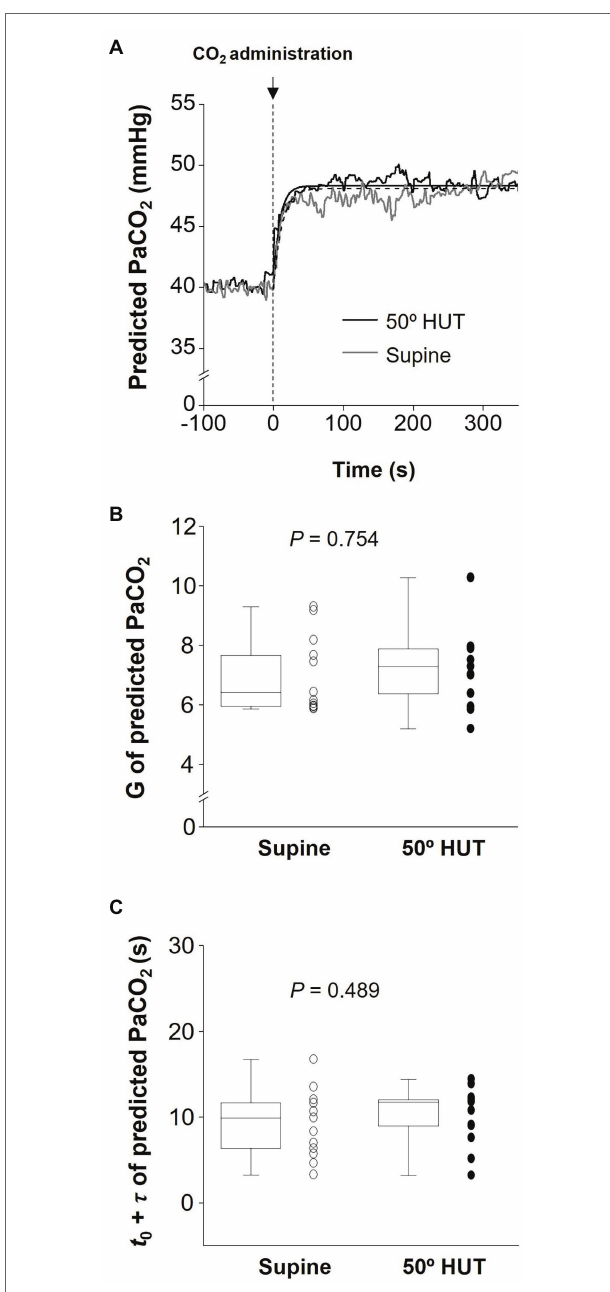
FIGURE 2 | Panel A : Continuous recording of predicted partial pressure of arterial CO 2 (PaCO 2 ) responses to CO 2 administration (5% CO 2 ) during supine (gray line) and 50 ° head-up tilt (HUT; black line) in one representative participant. The dash-dotted and smooth curve represent the exponential lines at supine and 50 ° HUT, respectively. Panel B : Group-averaged gain (G) of predicted PaCO 2 exponential fitting curves during supine and 50 ° HUT. Panel C : Grouped sum of CO 2 -response delay ( t 0 ) and time constant ( τ ) of predicted PaCO 2 exponential fitting curves during supine and 50 ° HUT. The predicted PaCO 2 was derived from P ET CO 2 and V t using the following equation (Jones et al., 1979); Predicted PaCO 2 = 5.5 + 0.9*P ET CO 2 –0.0021*V t . Grouped data are shown as median and interquartile range with individual data